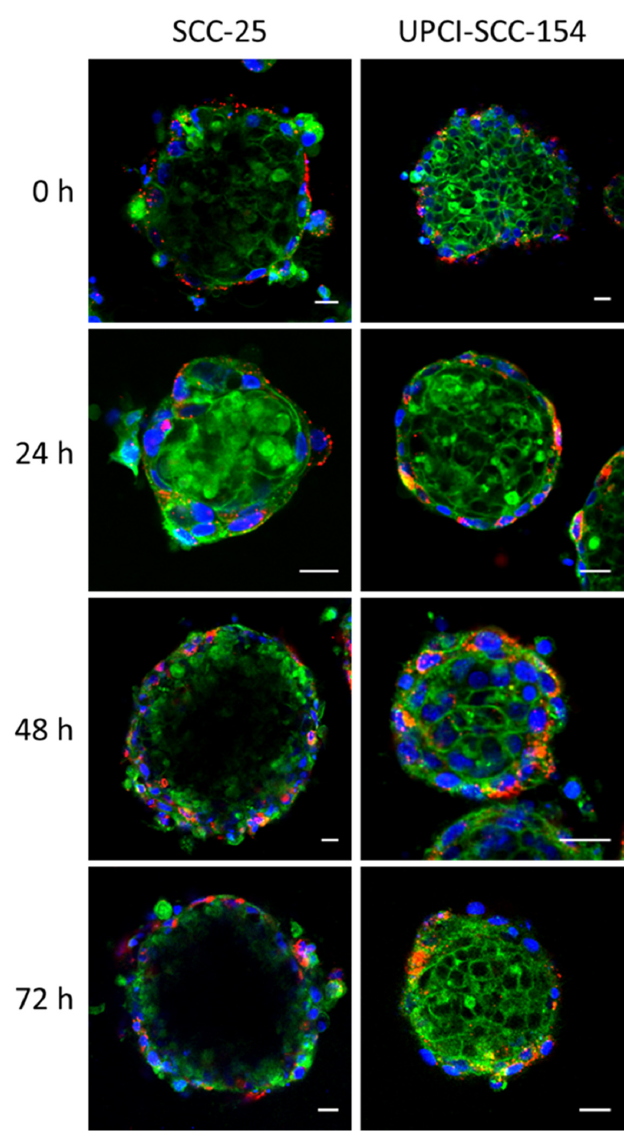
Figure 2. Confocal analysis of nanoparticles internalization in 3D models of HNSCC cell lines. SCC-25 and UPCI:SCC-154 spheroids were incubated with fluorescently labeled nanoparticles (NAs-647). A cell membrane marker (CellMask Green-488, Life Technologies) and Hoechst 33342 (Sigma) for nuclei were used. Spheroids were washed twice with PBS and imaged by confocal microscopy. Scale bar: 100 µm.